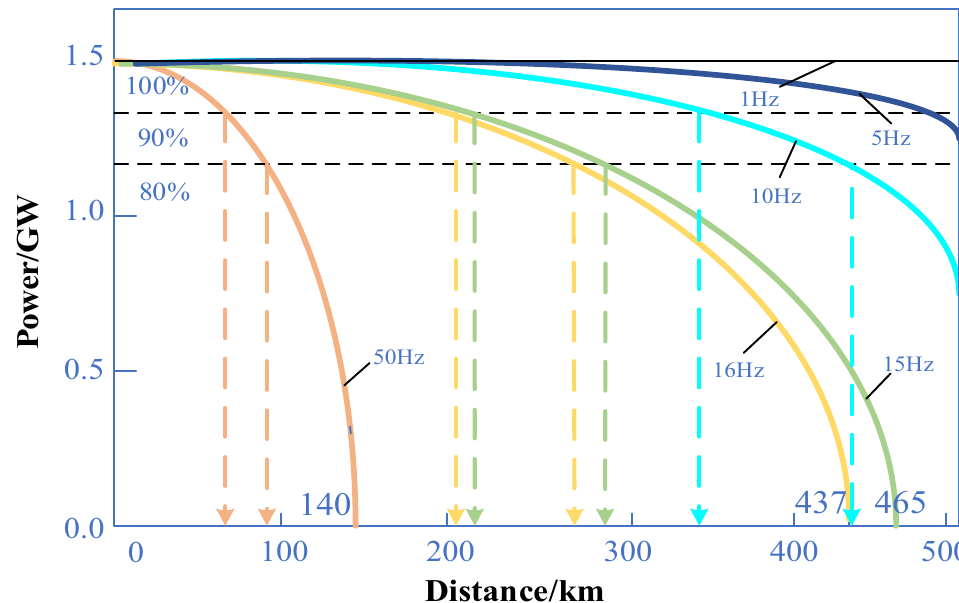
Fig. 5 Maximum transferable active power of cable as a function of length and frequency